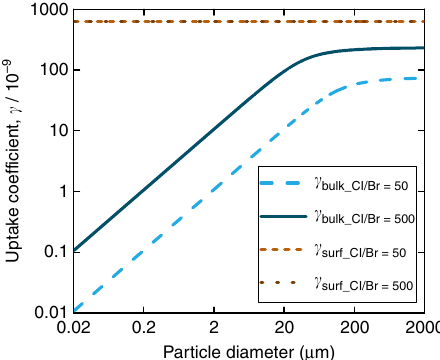
Fig. 5 Implications for ozone uptake under atmospheric conditions. Predicted uptake coef fi cient for bulk reaction only ( blue lines ) and uptake coef fi cient due to surface reaction only ( brown lines ) for deliquesced sea salt solution equilibrated at 80% relative humidity (4.0 M Cl − ) and a chloride to bromide ratio of 50 ( light blue and light brown lines ) and 500 ( dark blue and dark brown )), as a function of the diameter of a spherical brine droplet or aerosol particle. The brown lines overlap, because the surface coverage of the bromide ozonide complex, and thus also the surface reaction rate, does not depend on the bromide concentration in the aqueous phase within the relevant range. This plot emphasizes the predominance of a surface process, especially for smaller particle